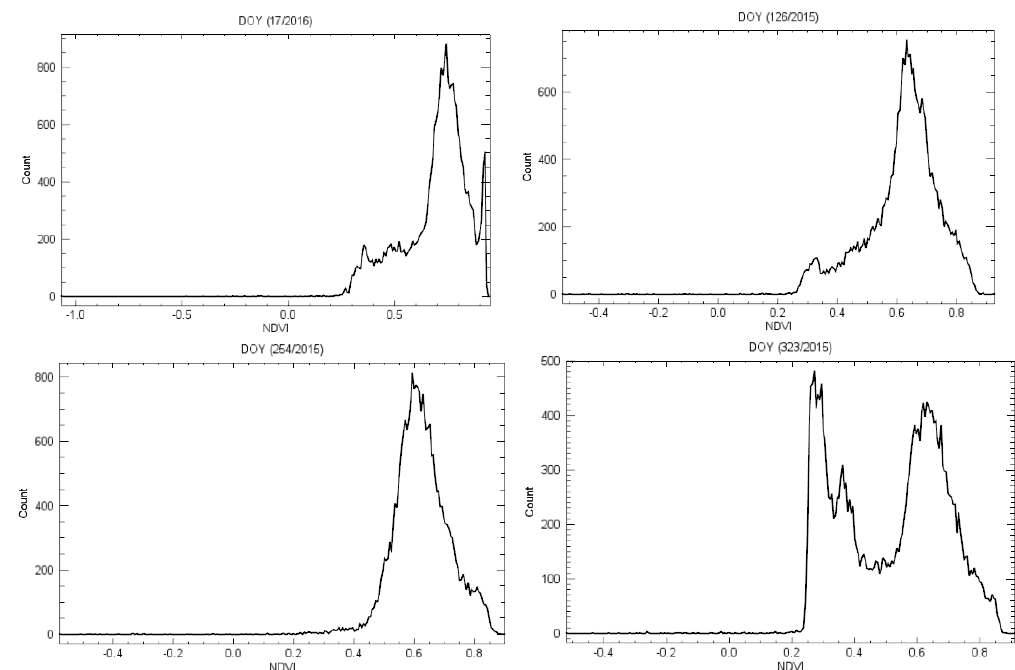
Figure 3. NDVI distribution for the study area for a summer season scene (DOY 17); autumn season scene (DOY 126); winter season scene (DOY 254) and a spring season scene (DOY 323).